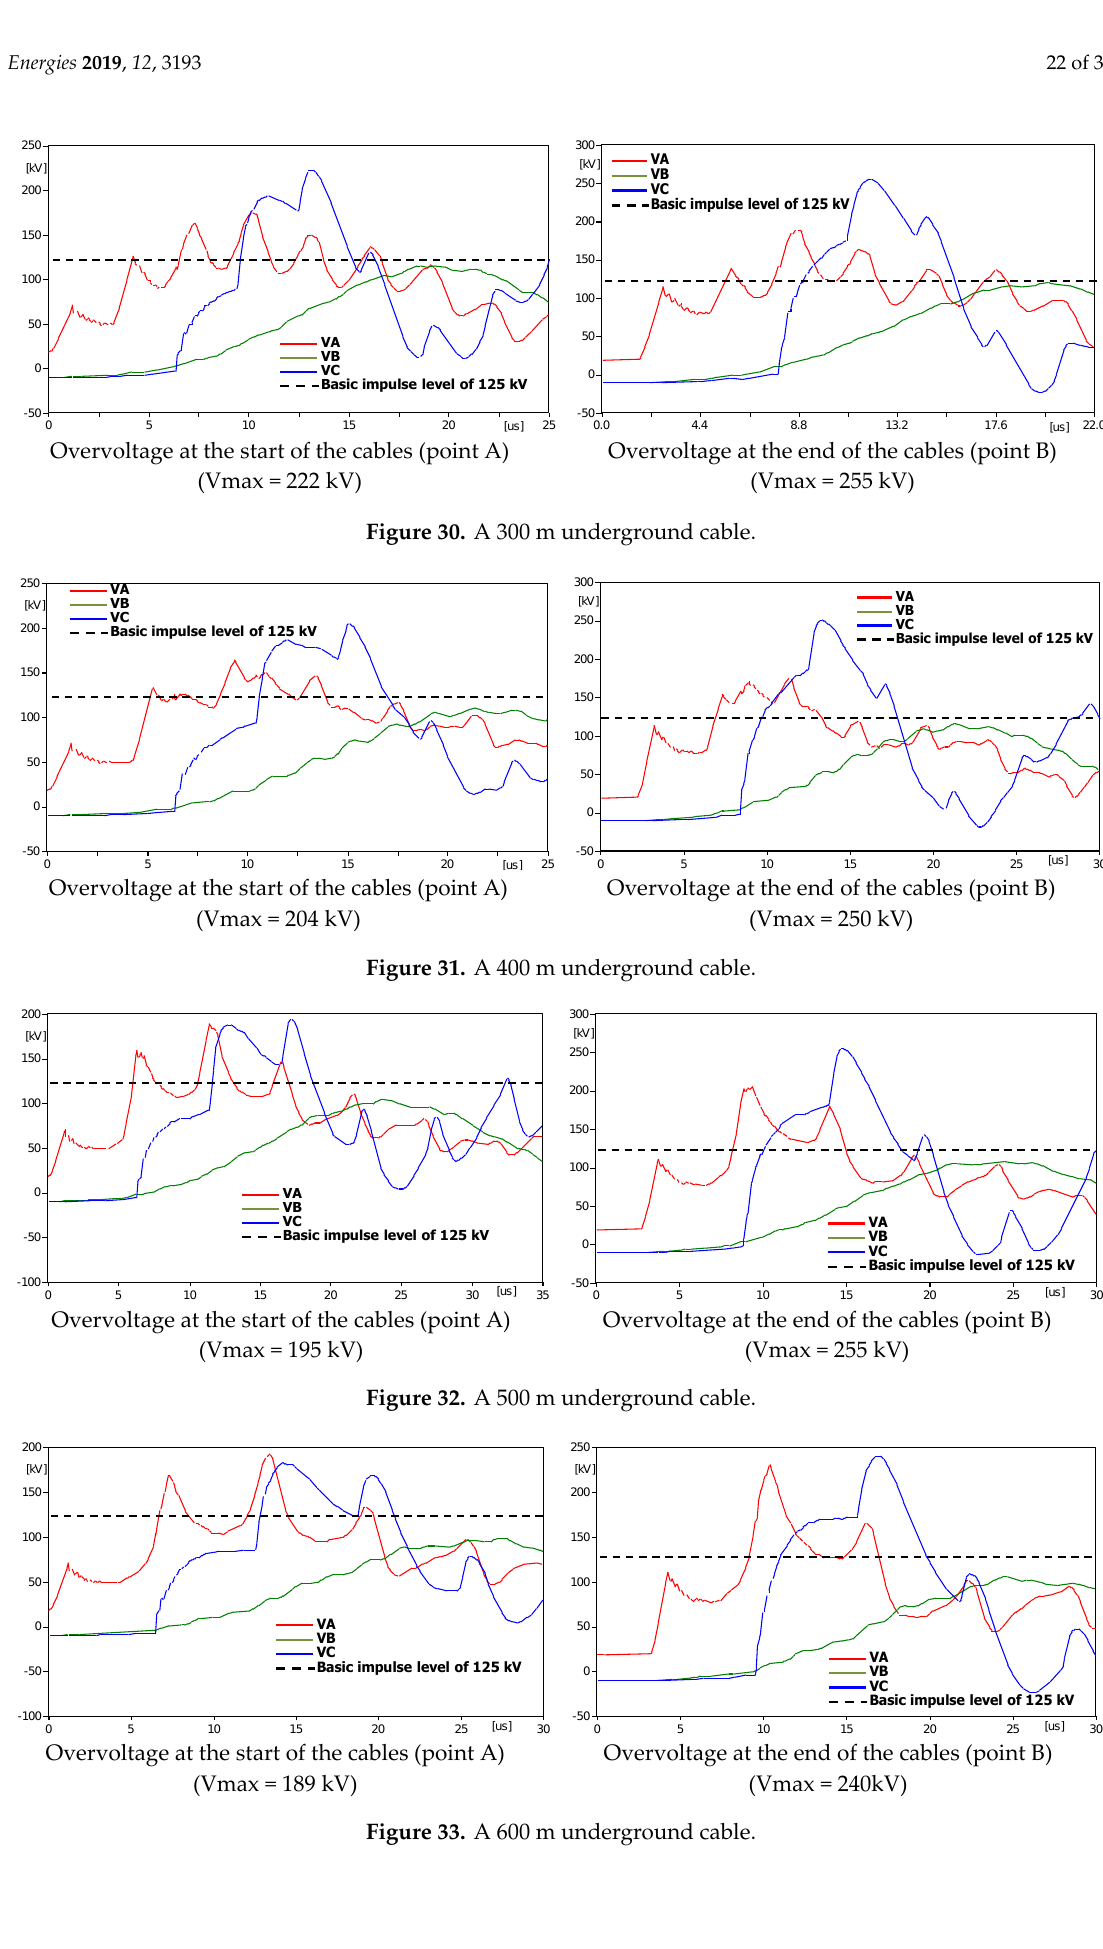
(Vmax = 274 kV) Figure 28. A 100 m underground cable.